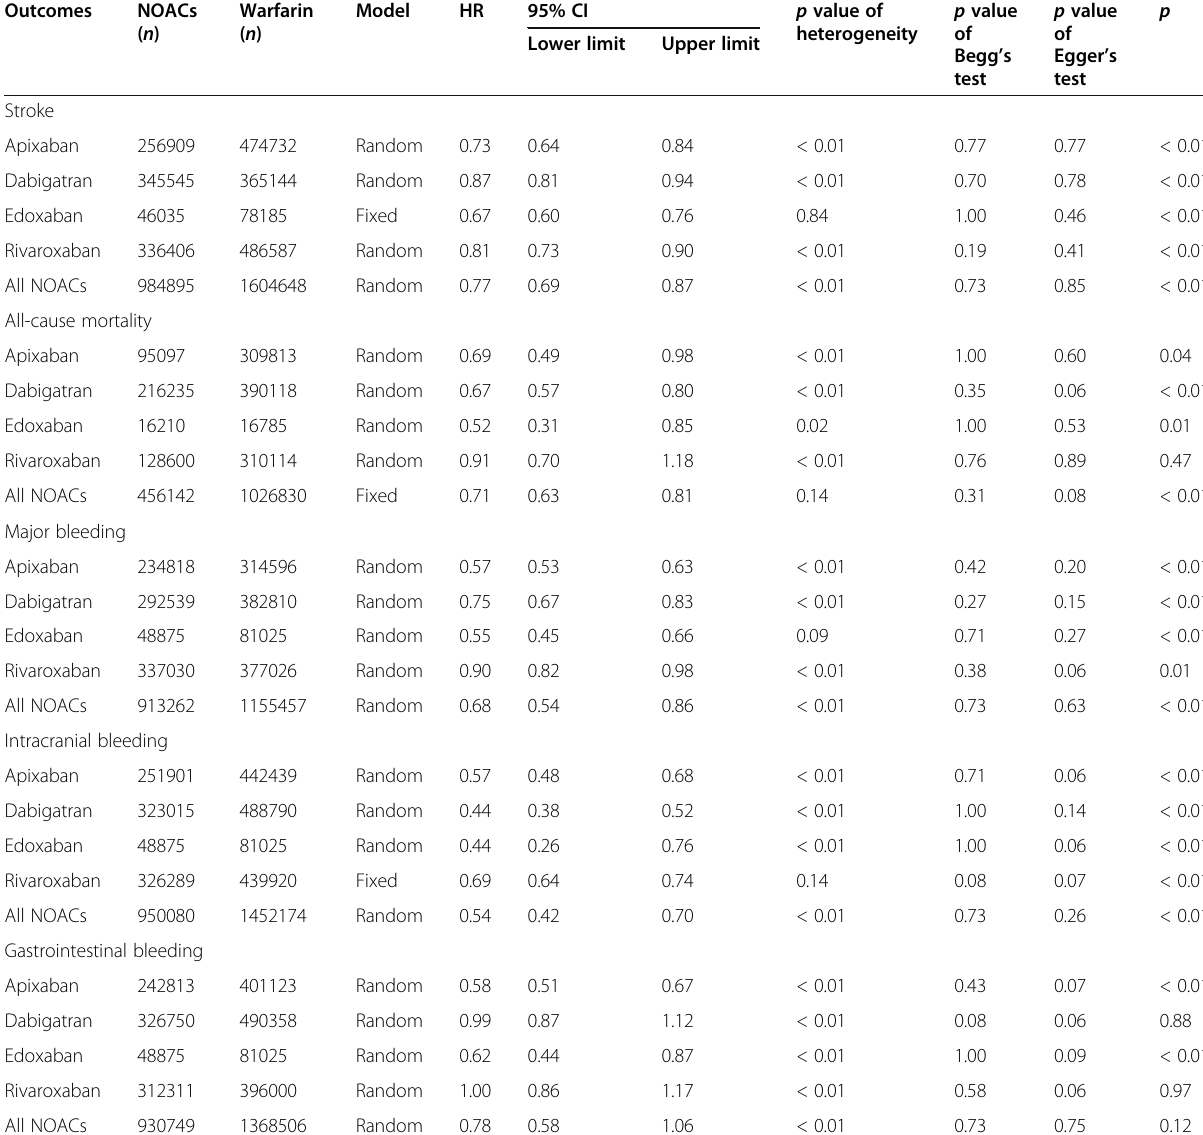
Table 2 Summary of the outcomes of interest